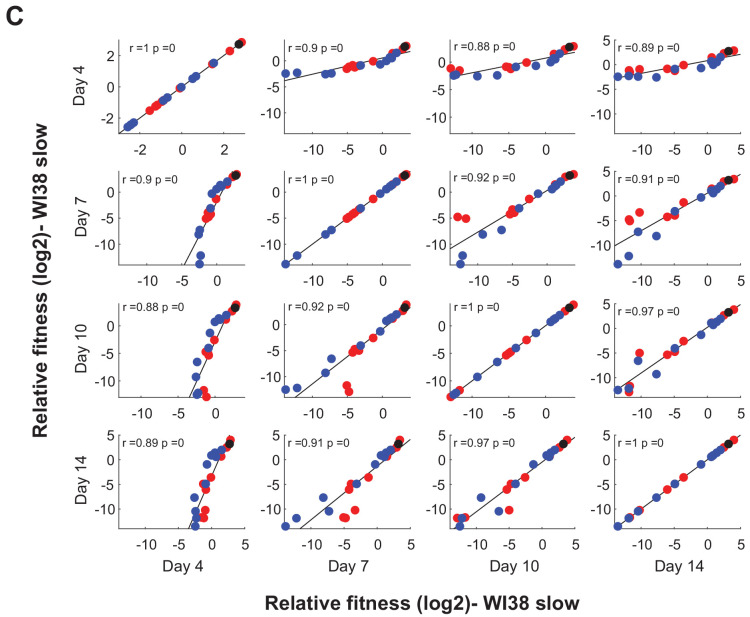
Comparison between relative fitness of tRNA- targeted cell in different time points of iCas9 induction.Continue from Figure 4—figure supplement 1.